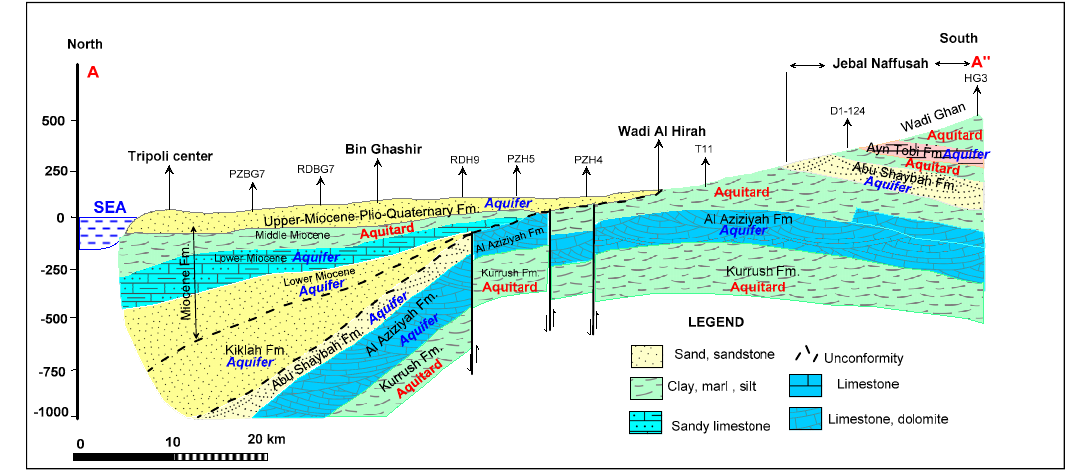
Figure 2. Geological cross-section in the coastal area of Jifarah Plain, including Tripoli region. Table 1. Description of the Upper-Miocene-Pliocene-Quaternary deposits in the coastal area of Jifarah Plain around Tripoli.